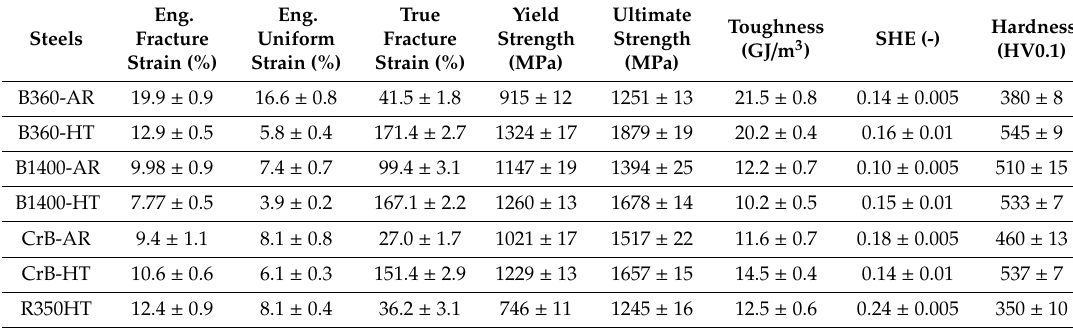
Table 3. The values of mechanical (tensile) properties for each